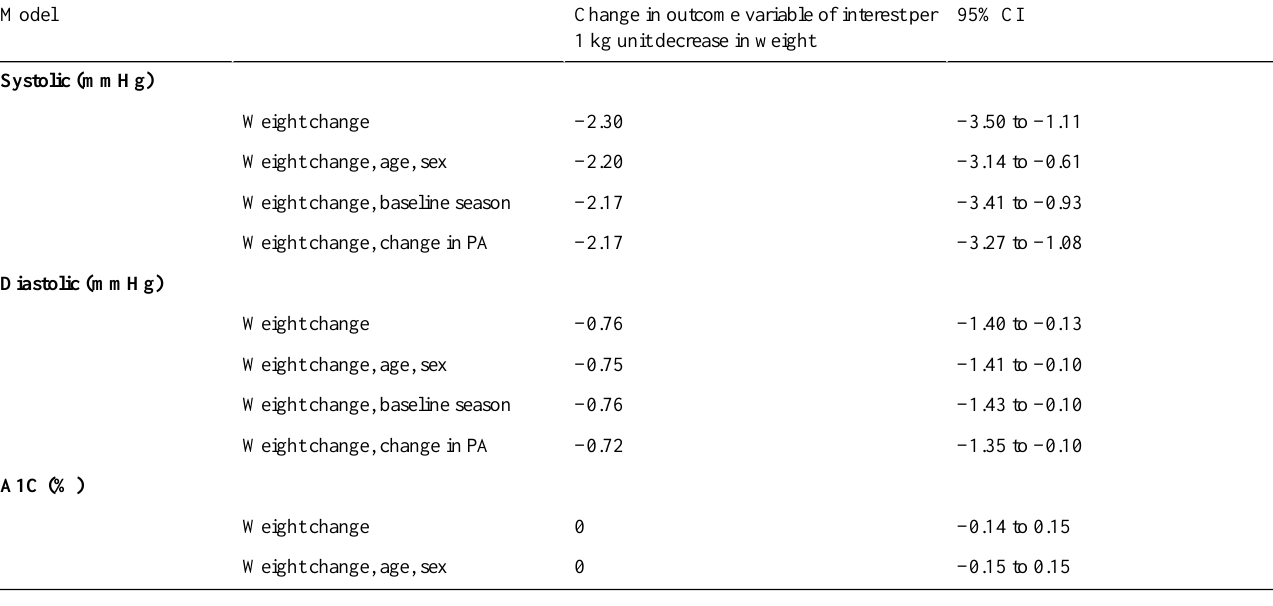
Table 3. Linear regression models examining relationships between weight change and changes in blood pressure and hemoglobin